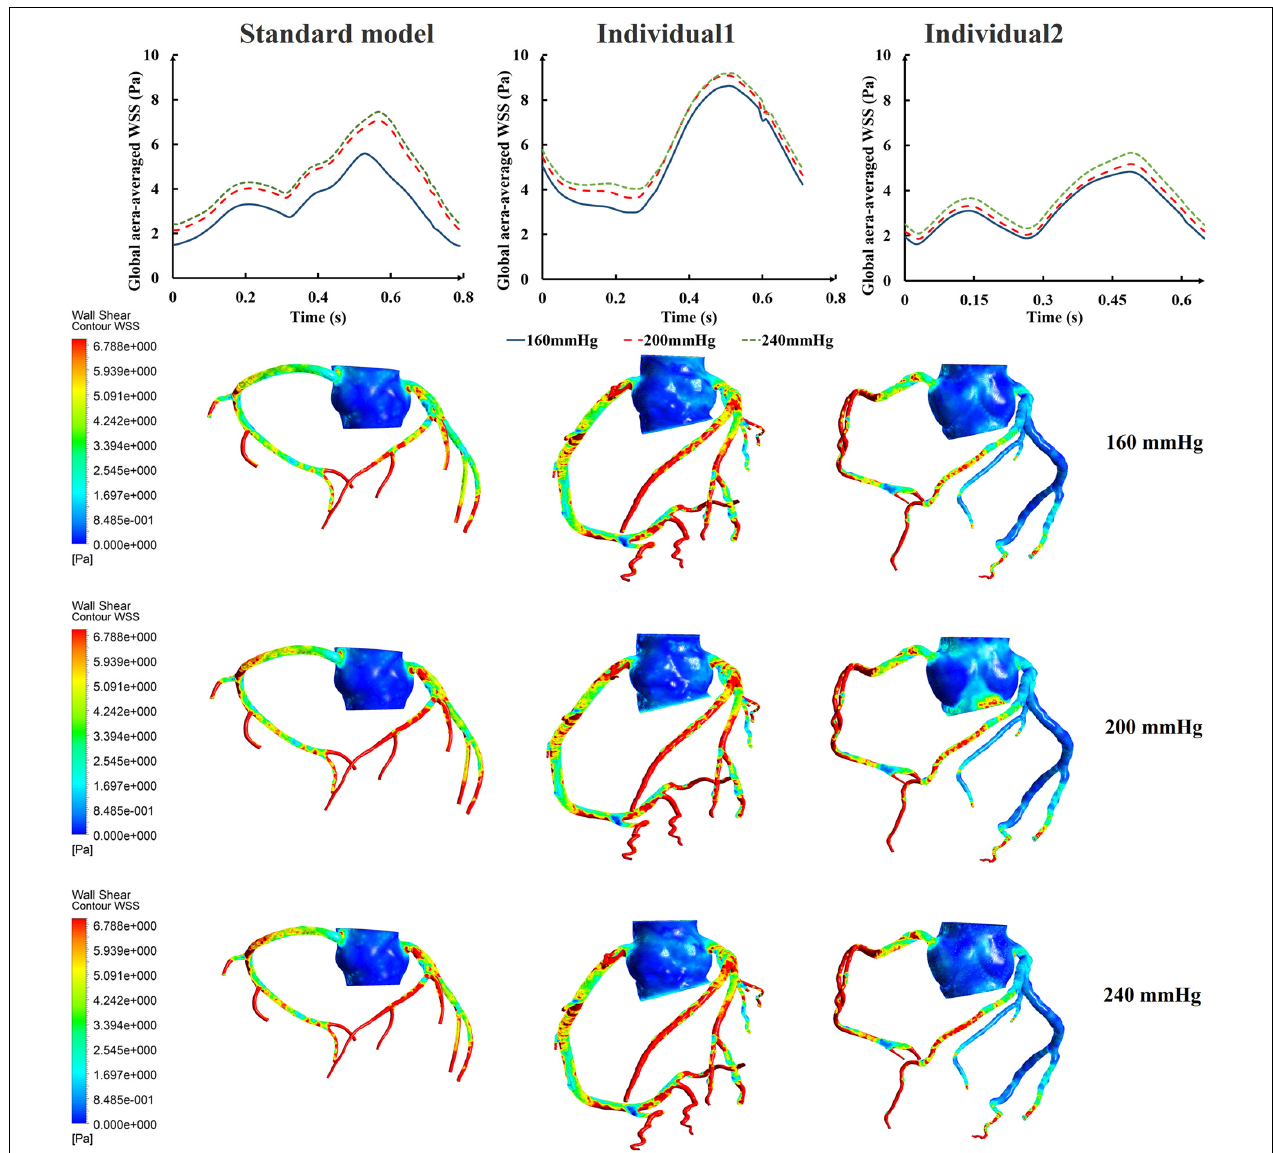
FIGURE 5 | The variations of global area-averaged WSS and the maximum flow moment WSS of three coronary arteries under different pressure